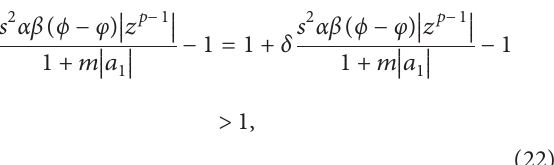
� 0 . 0015 + 0 . 00001 i , a � 1/2 , a � 0 1 2 � 0 . 0071 + 0 . 0014 i , a � 2 , a � 1, 0 1 2 � 0 . 006 i , a � 2 , a � 1, a, b, s, m � 0 1 2